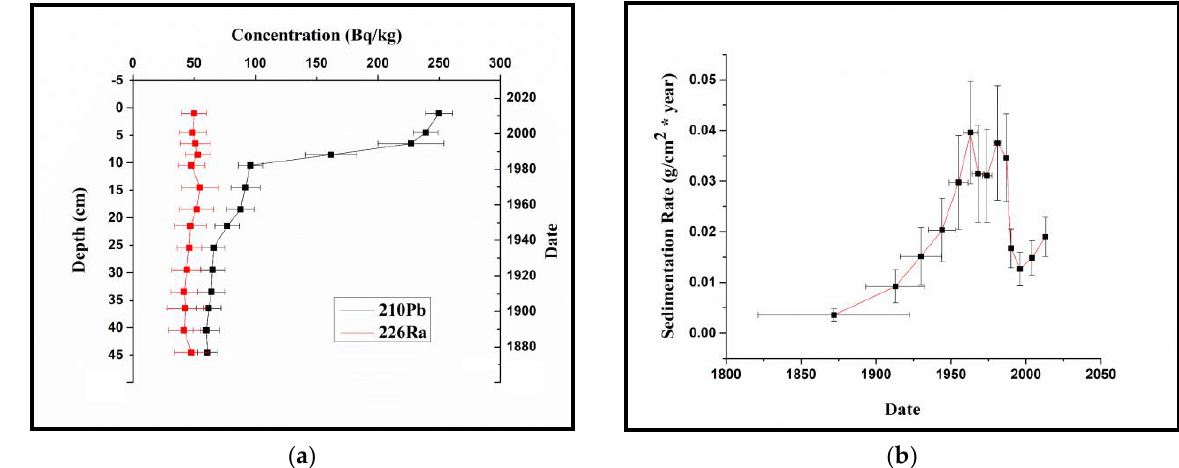
Figure 2. 210 Pb and 226 Ra concentrations ( a ) and sedimentation rate ( b ) in Lacu Sărat Lake.